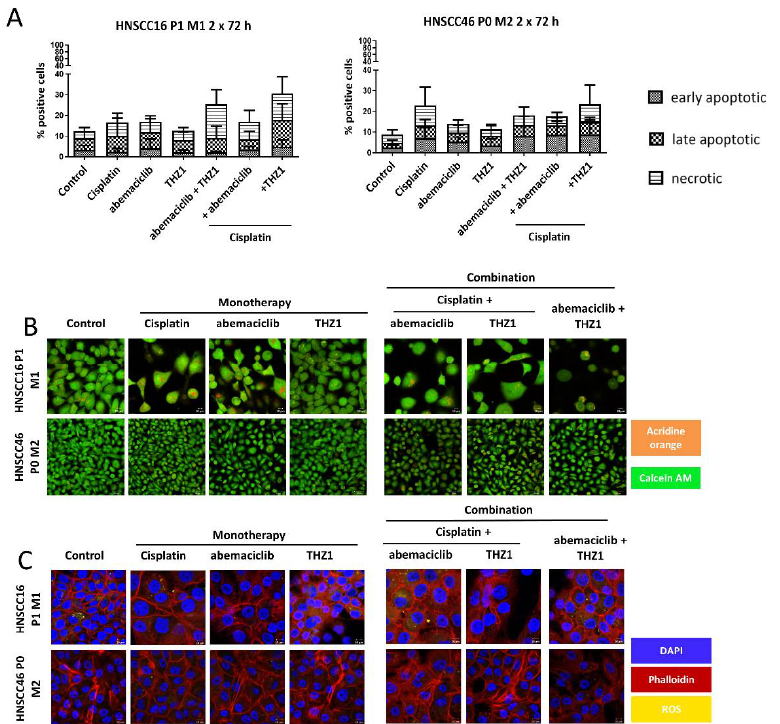
Figure 5. Apoptosis-necrosis assay, detection of acidic components, the cytoskeleton, and reactive oxygen species (ROS). Drug doses were abemaciclib [HNSCC16 P1 M1/HNSCC46 P0 M2: 1